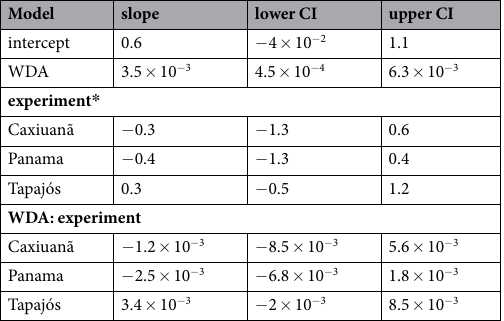
throughfall exclusion experiment in which both saplings and trees were studied, the ratio of drought:control mortality was four times greater for trees than saplings (see Supplementary Table S4). Our results allowed us to identify the vulnerability of particular taxa. Drought-mortality was greater than base- line mortality across more than one experiment for 22 of the 51 genera that occur in at least two different studies (Supplementary Table S5). Among these vulnerable genera, we highlight Inga and Hymenaea (Leguminosae), Pouteria (Sapotaceae), Casearia (Salicaceae), Guarea (Meliaceae), Virola (Myristicaceae), Licaria (Lauraceae) and Eschweilera (Lecythidaceae). Only five genera ( Capparidastrum [Capparaceae], Faramea [Rubiaceae], Garcinia [Clusiaceae], Socratea [Arecaceae] and Miconia [Melastomataceae]) were consistently resistant, with drought treatment mortality rates lower than or equal to the baseline mortality.